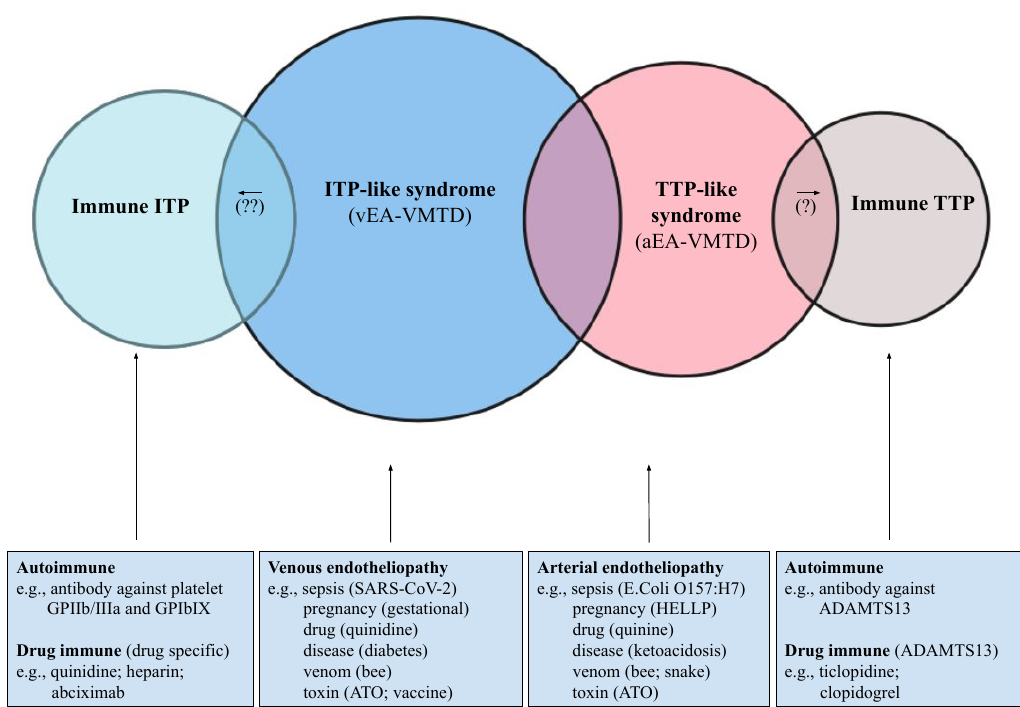
Figure 5. Projected distribution of acquired consumptive and immune-related thrombocytopenic syndromes (model based on endotheliopathy). Thrombocytopenia is often a mysterious origin in clinical medicine. It is very common in sepsis and critical illnesses, including diabetic complication, stroke, heart attack, autoimmune disease, hemostatic diseases, and of course, the side effects of many drugs. It has been typically interpreted as the condition due to decreased production from suppressed bone marrow, increased destruction due to the immune mechanism, or increased utilization, such as in diseases such as TTP-like syndrome. Still, the pathogeneses of a large number of thrombo- cytopenia could not be identified, and often itx has been called ITP, “idiopathic”, or “immune”. Because endotheliopathy has been found to be due to consumptive thrombocytopenia following microthrombogenesis in the lone ULVWF path of hemostasis, it has become clear that the largest number of thrombocytopenia is the result of consumption, which can be manifested differently in intersecting relationship between venous and arterial endotheliopathy, as well as immune-related mechanisms, and this clarifies the mystery of ITP/ITP-like syndrome and TTP/TTP-like syndrome. The figure is self-explanatory showing overlapping concepts. Abbreviations: ATO: arsenic trioxide; aEA-VMTD: arterial endotheliopathy-associated vascular microthrombotic disease; vEA-VMTD: venous EA-VMTD; HELLP: hemolysis, elevated liver enzymes, and low platelet syndrome; ITP: immune thrombocytopenic purpura; TTP: thrombotic thrombocytopenic